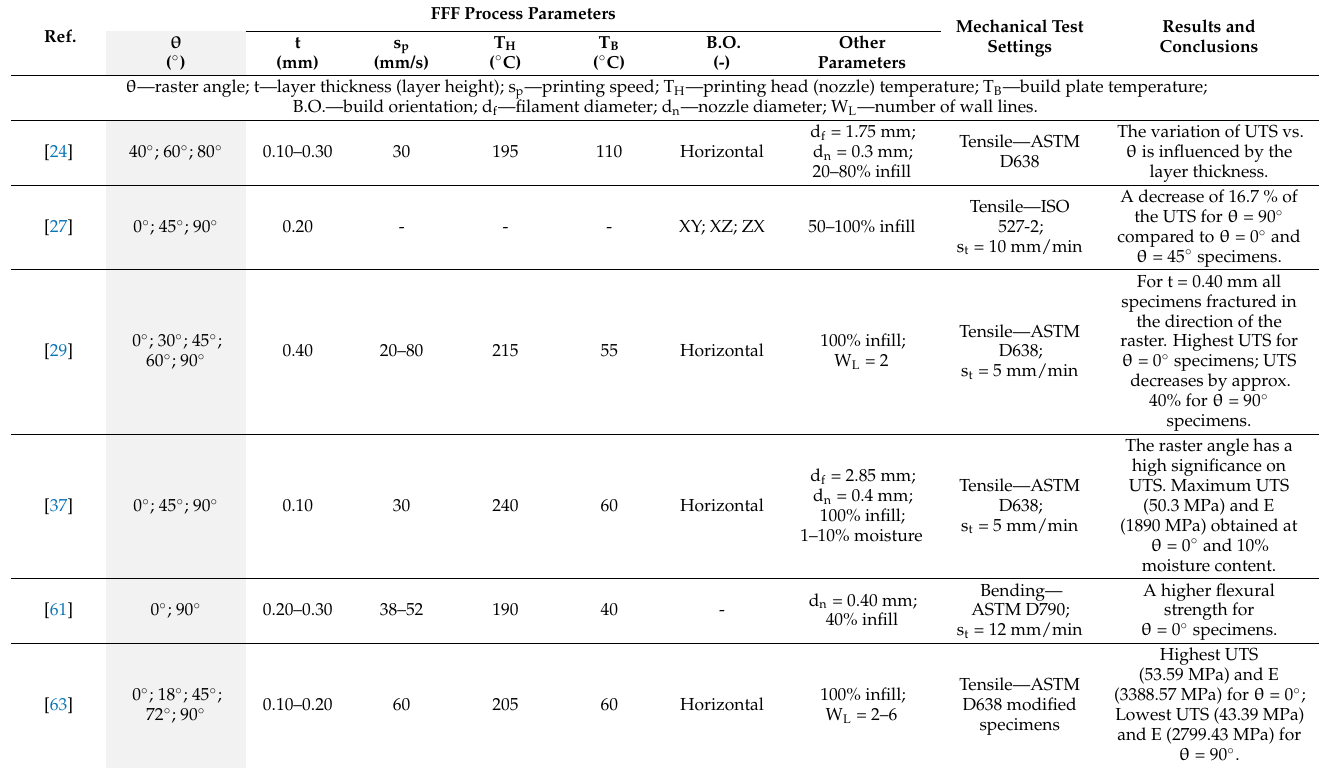
Table 6. The influence of the raster angle on the mechanical properties of FFF-printed